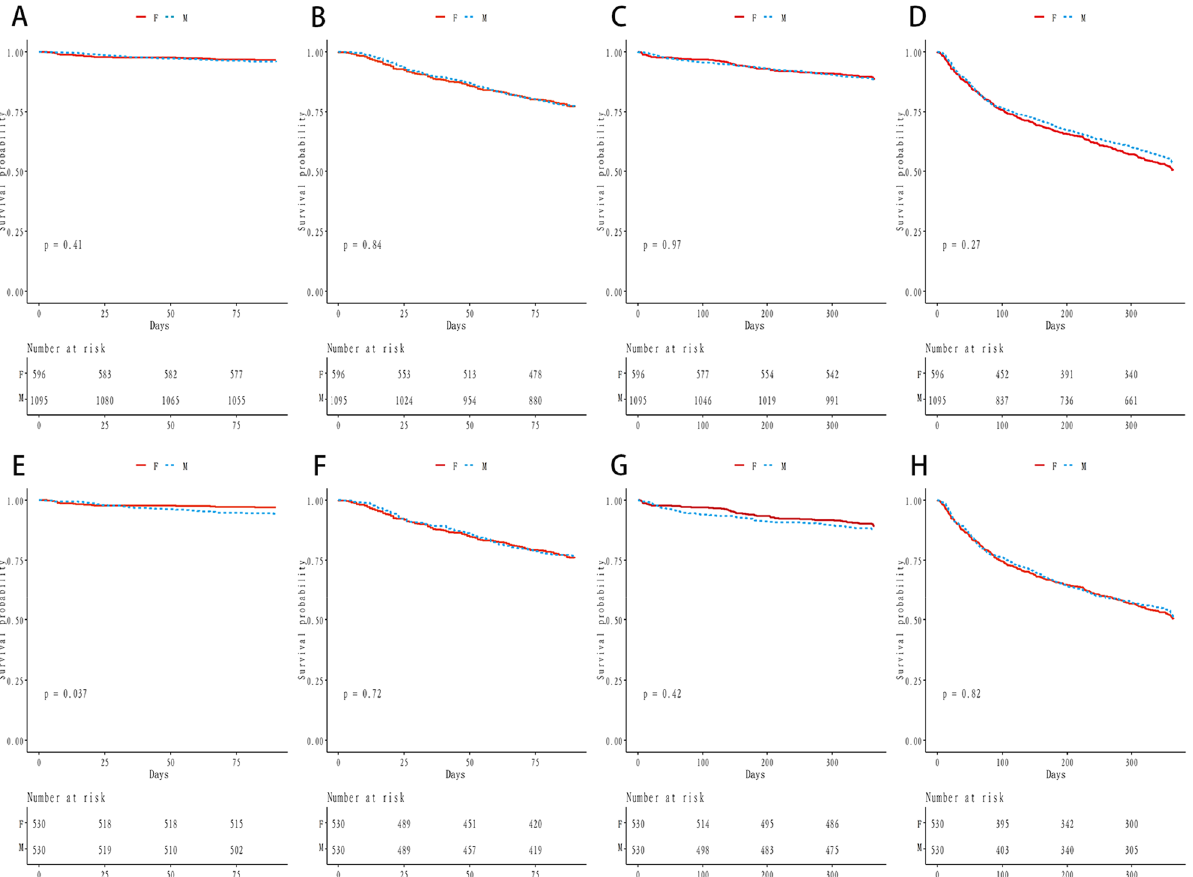
Figure 2. Kaplan–Meier curves of outcomes before and after PSM matching. ( A ) The cumulative 90-day all- cause mortality (before PSM matching). ( B ) The cumulative 90-day CV events (before PSM matching). ( C ) The cumulative 1 year all-cause death (before PSM matching). ( D ) The cumulative 1 year CV events (before PSM matching). ( E ) The cumulative 90-day all-cause mortality (after PSM matching). ( F ) The cumulative 90-day CV events (after PSM matching). ( G ) The cumulative 1 year all-cause death (after PSM matching). ( H ) The cumulative 1 year CV events (after PSM